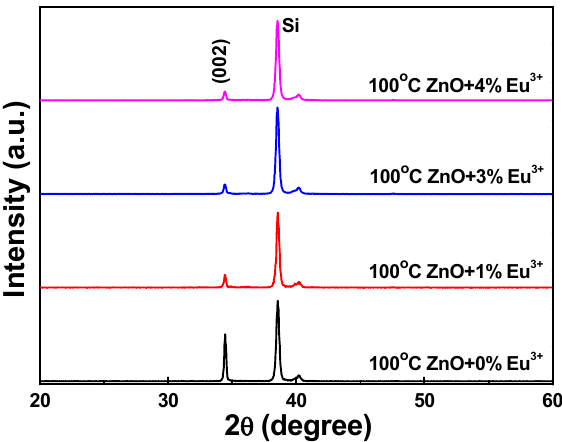
Figure 2. X-ray diffraction (XRD) patterns of synthesized Eu 3+ -doped ZnO nanowires as a function Figure 2. X-ray di ff raction (XRD) patterns of synthesized Eu 3 + -doped ZnO nanowires as a function of of the concentration of Eu 3+ ions; the synthesis temperature was 100 °C. the concentration of Eu 3 + ions; the synthesis temperature was 100 ◦